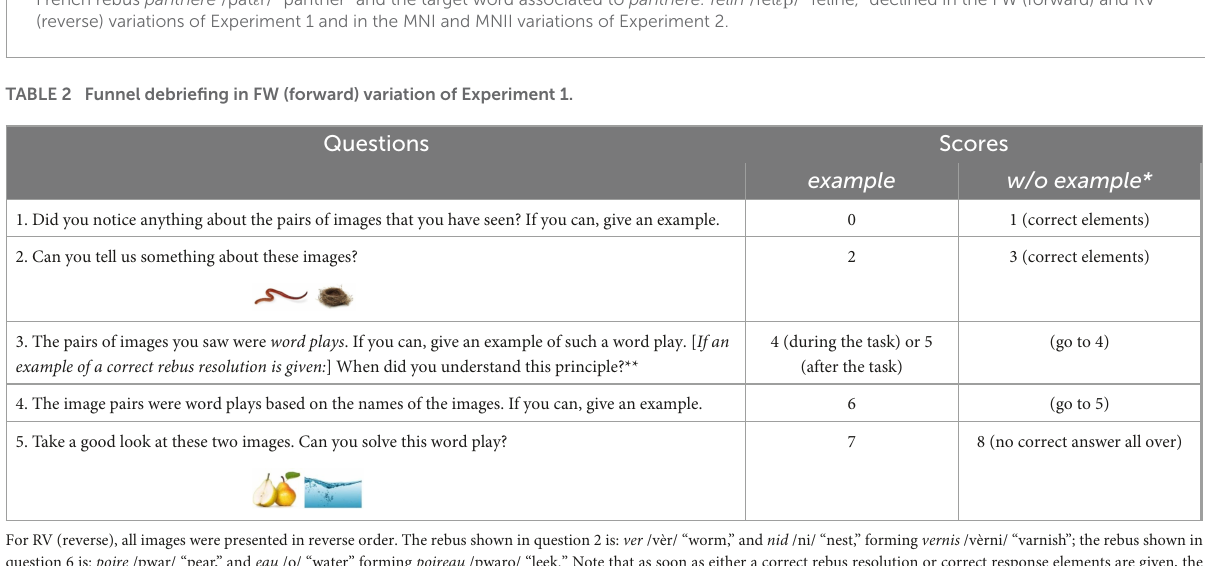
/ “feline,” declined in the FW (forward) and RV þ